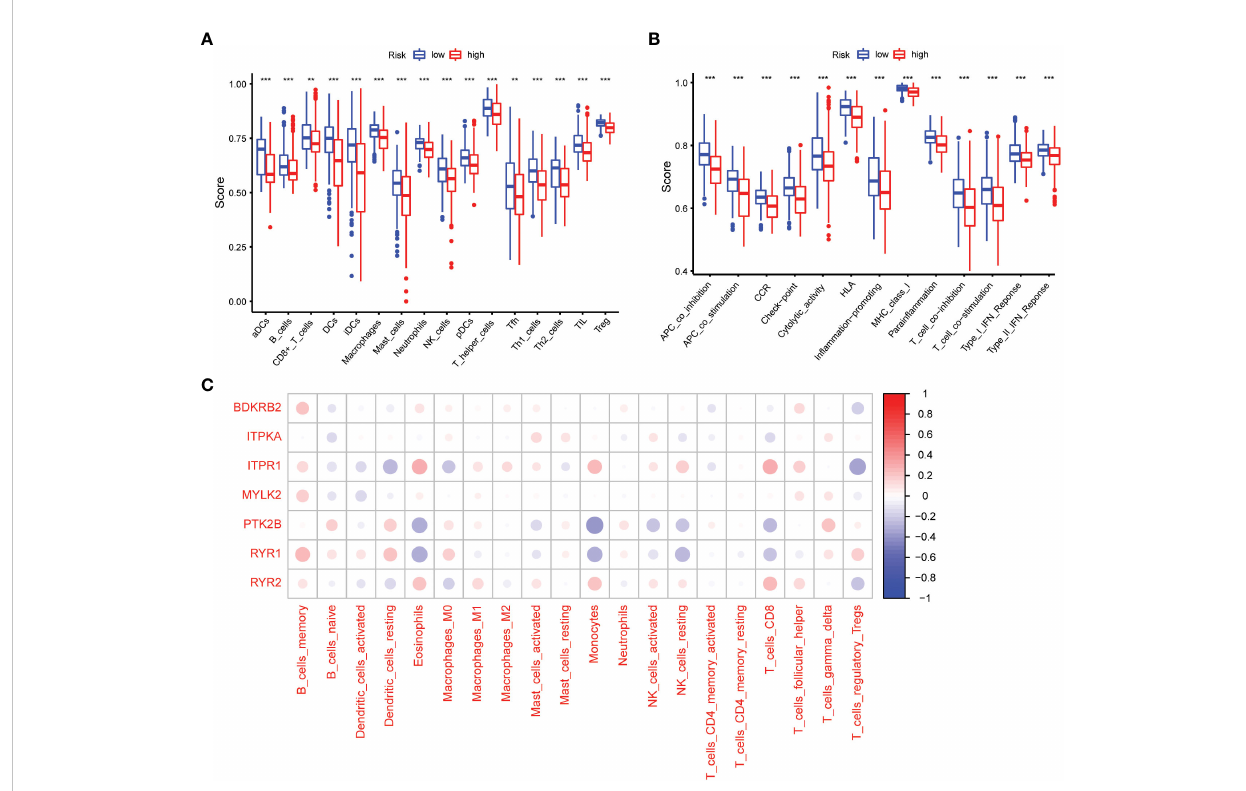
FIGURE 7 Comparison of the ssGSEA scores between different risk groups. (A) The scores of 16 immune cells. (B) The scores of 13 immune-related functions. Adjusted P values were showed as: **, P< 0.01; ***, P< 0.001. (C) The association between 7 prognostic calcium metabolism related genes and immune